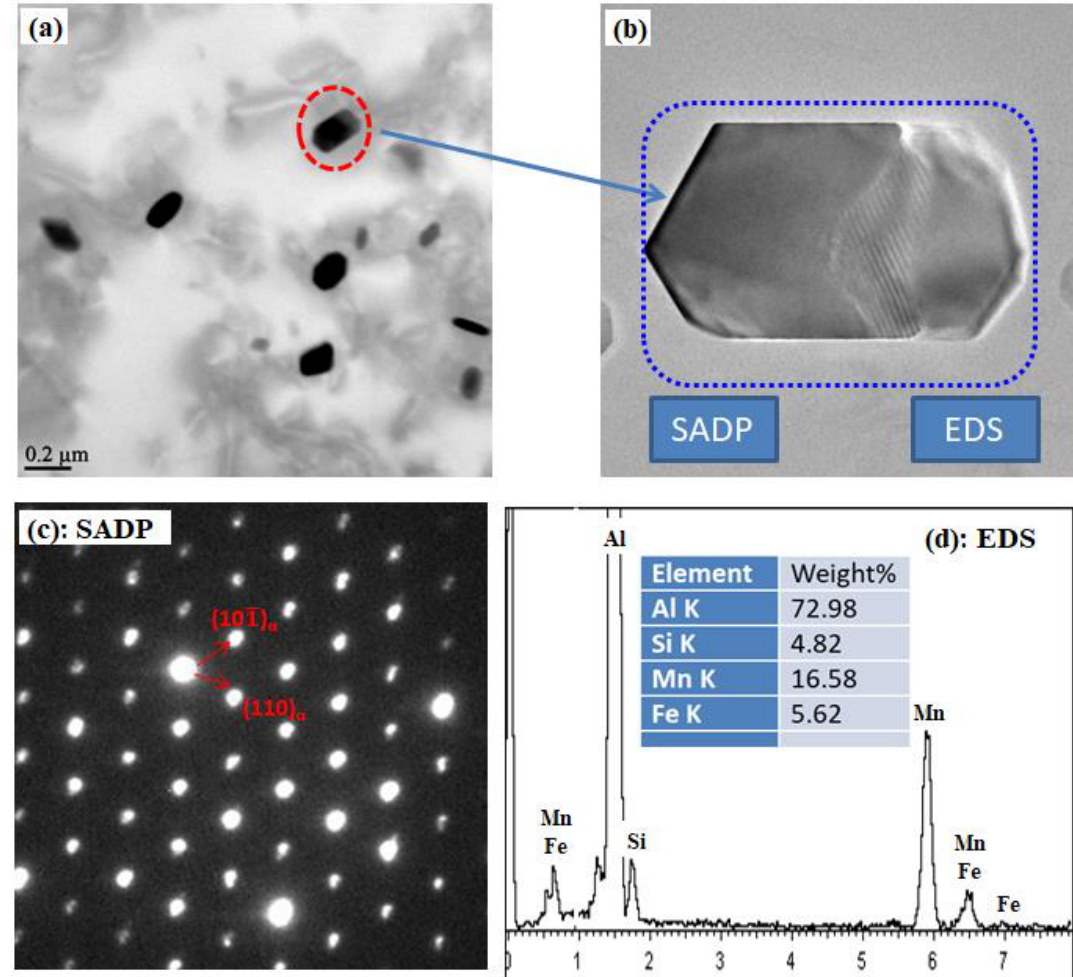
Figure 1. Dispersoids after A6 and its selected area diffraction pattern (SADP), as well as the EDS results: ( a ) Distribution of dispersoids ( b ) Dispersoid particle; ( c ) SADP of dispersoid in (b); ( d ) EDS result of dispersoid in (b).